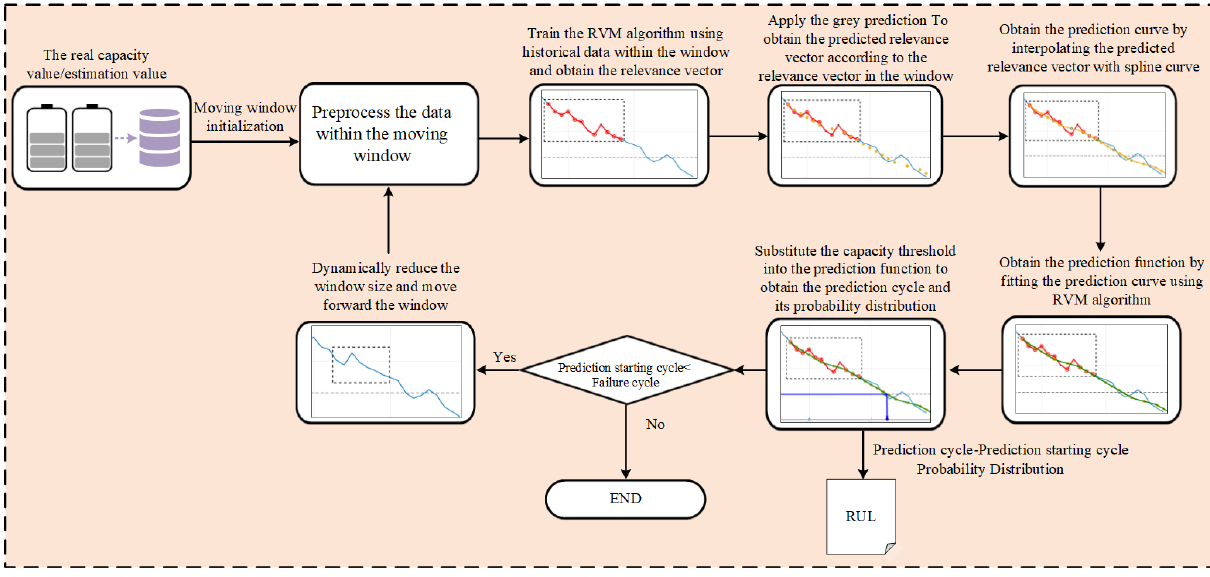
Figure 1. The RVM-GM algorithm for RUL prediction with dynamic size of moving window.